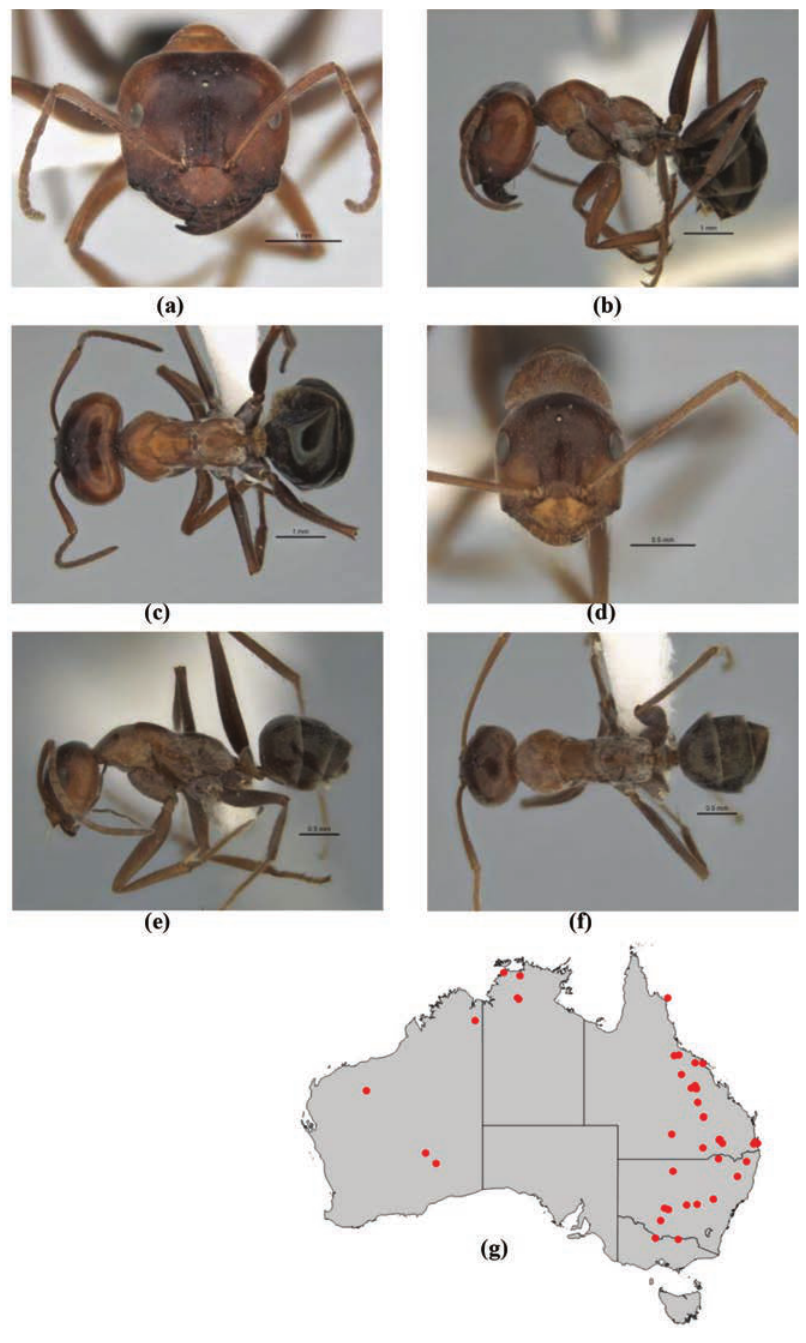
Figure 11. Melophorus curtus Forel: non–type major worker (ANCI32-900019–top ant) frons ( a ), pro- file ( b ) and dorsum ( c ); non–type minor worker frons (ANCI32-900019–bottom ant) ( d ), profile ( e ) and dorsum ( f ); distribution map for the species ( g ). Low resolution scale bars: 1 mm ( a–c ); 0.5 mm ( d–f